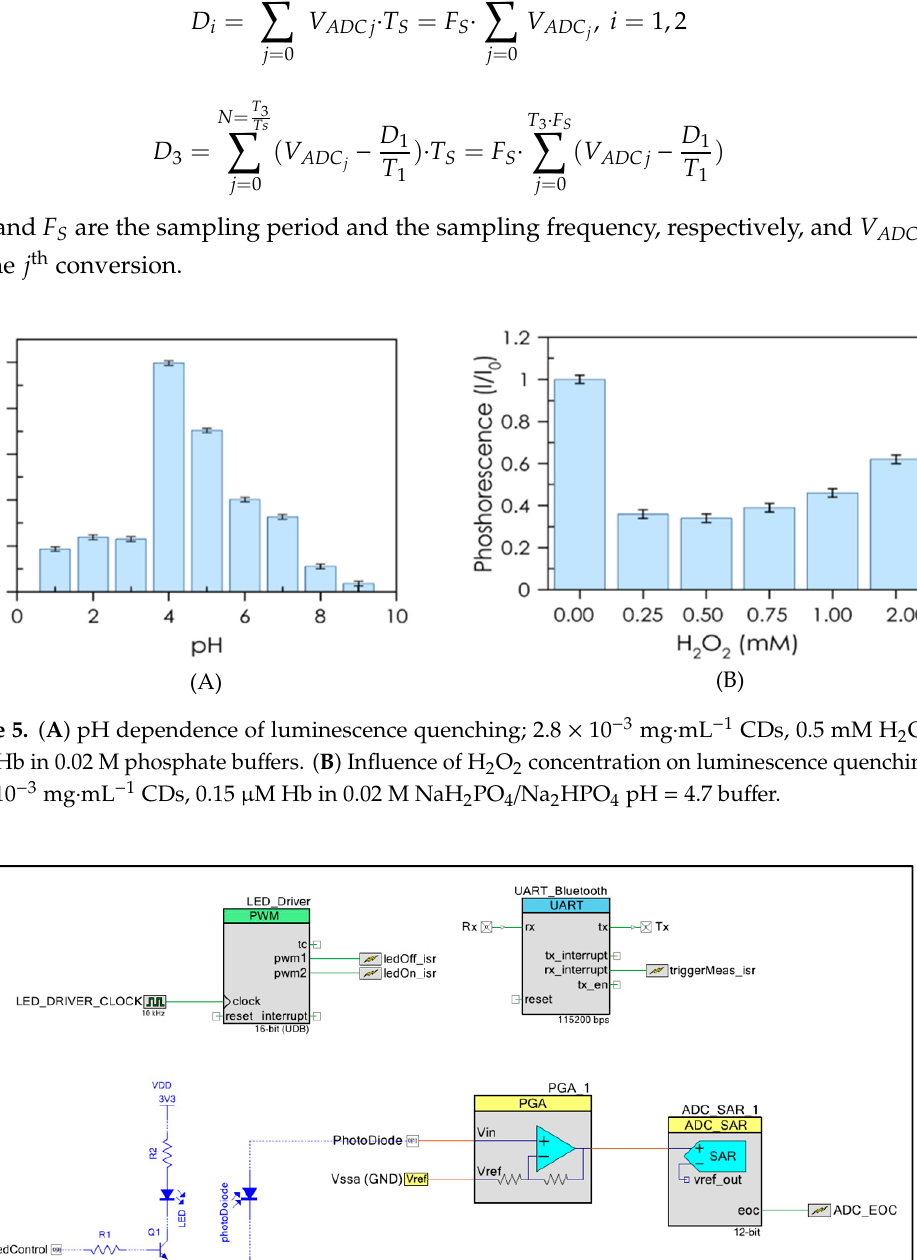
Figure 7. A 3D model ( A ) and real view ( B ) of the final portable instrument. 3.6. Interference Study One of the major challenges in the determination of Hb is the selectivity required in the presence of interfering ions and various biologically important species commonly found in real samples that may hamper the analytical application to Hb sensing. To evaluate whether this approach is highly specific for Hb, the quenching of CD suspensions was recorded in the presence of different interfering species, both molecules and ions (final concentration of 10 μ M) typically found in blood samples, i.e., ascorbic acid, glucose, uric acid, K + , Mg 2+ , Na + , and Ca 2+ . None of these species elicited a discernible effect on the phosphorescence response of CDs/H 2 O 2 for the determination of Hb (Figure 8). These results confirm that neither inorganic nor organic analytes found in blood interfere with our assay, validating the selectivity of the phosphorescence system towards Hb.